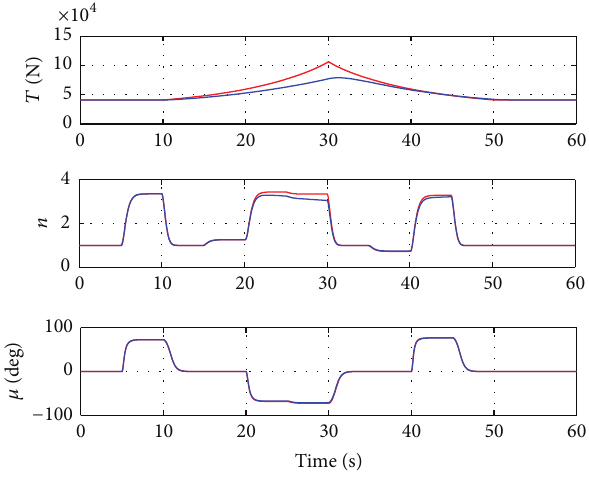
Figure 1: The system responses of the UAV.